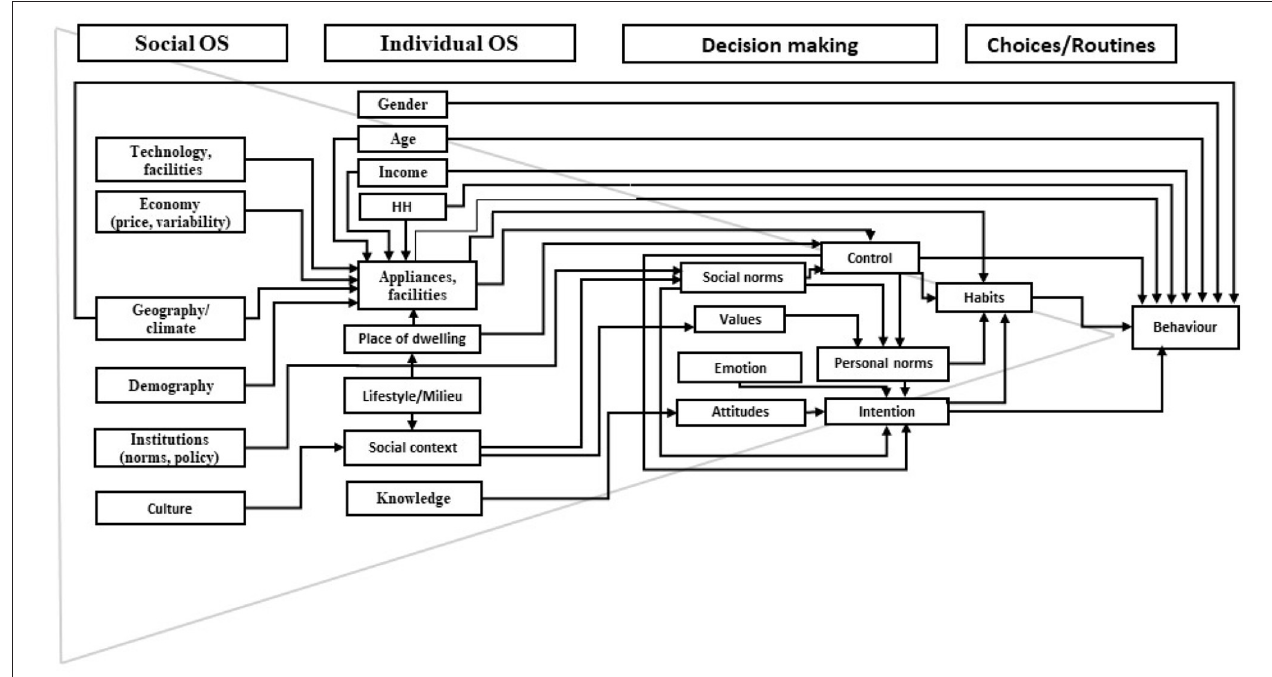
FIGURE 2 | Generic interdisciplinary model of ECB developed from the IHECF (Burger et al.,